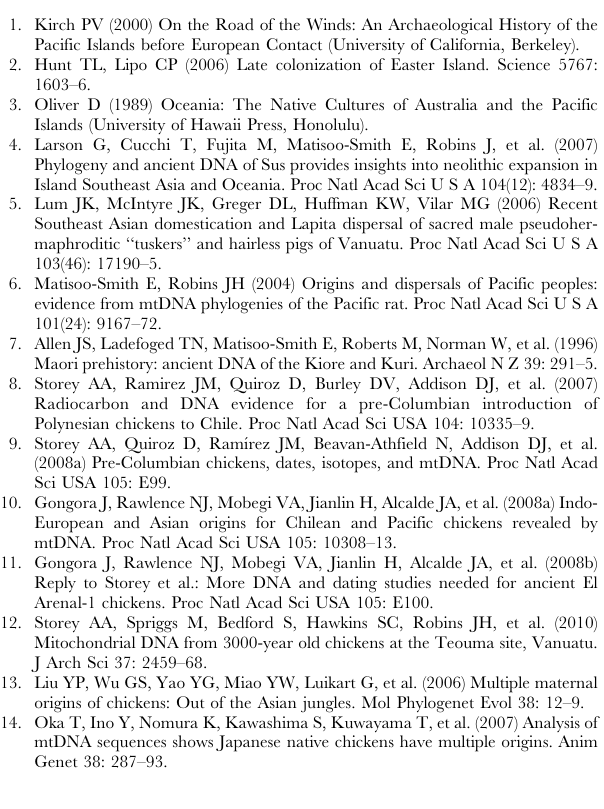
Figure S1 Location of Vanuatu in relation to Australia and New Guinea (inset) and sampling locations. Table S1 Nucleotide polymorphisms in contemporary Vanuatu